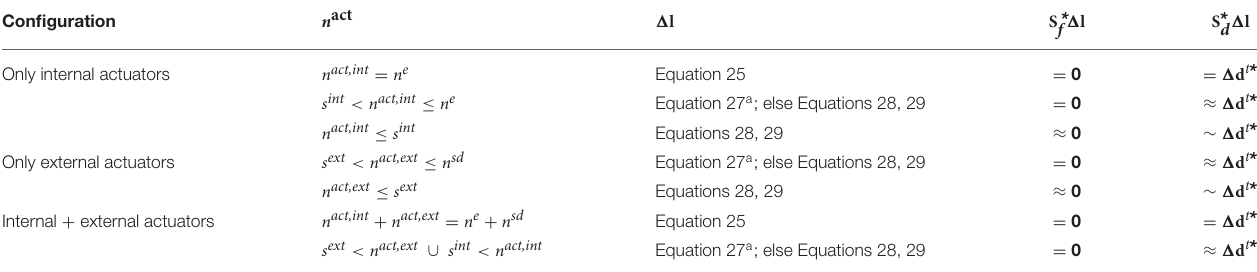
TABLE 2 | Shape control through impotent eigenstrain .